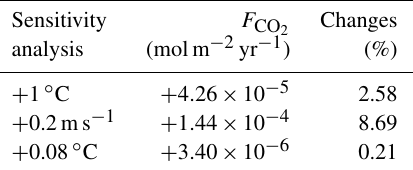
Table D1. Changes in air–sea CO 2 exchange (molm − 2 yr − 1 and %) regarding the sensitivity of the system towards the interplay be- tween CO 2 and heat. For the first sensitivity analysis, the SST is increased by 1 ◦ C, while for the second analysis, the annual mean wind speed is raised by 0.2ms − 1 . The third row corresponds to the maximum difference of SST between the simulations.